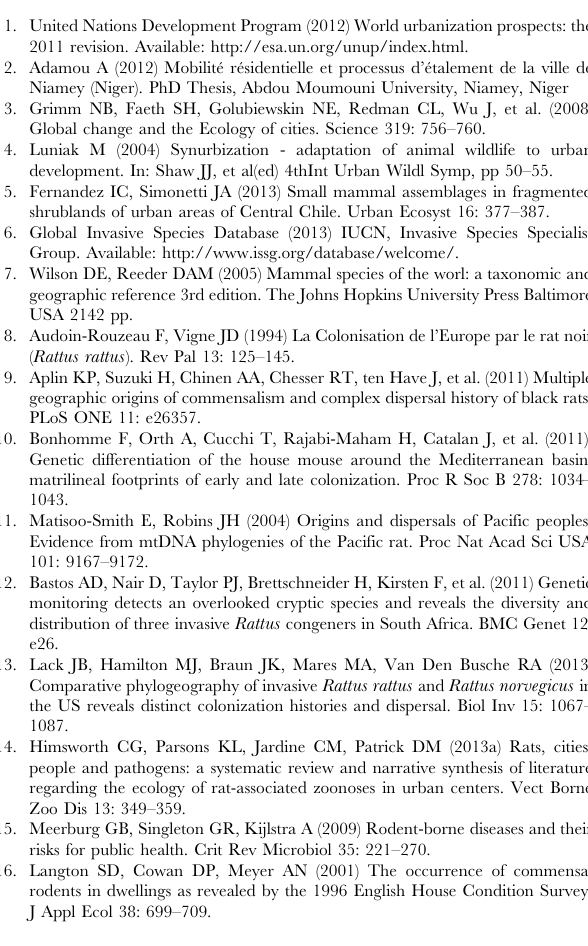
Table S1 Trapping-based inference of detection/non- detection as well as probability of detection in each of the 166 SP trapping sites investigated by occupancy modelling. Trapping sites are labelled according to a ‘‘C-XXX- N’’ code (where ‘‘XXX’’ refers to a locality and ‘‘N’’ is an unique number within this given locality), except ‘‘ABA’’ and ‘‘KIR’’ which correspond to the two industrial sites (see text for details). Table S2 Model selection results for Rattus rattus , Mus musculus , and Mastomys natalensis , where y is the probabilities of presence and p is the probability of detection of the species in a trap. Models are compared